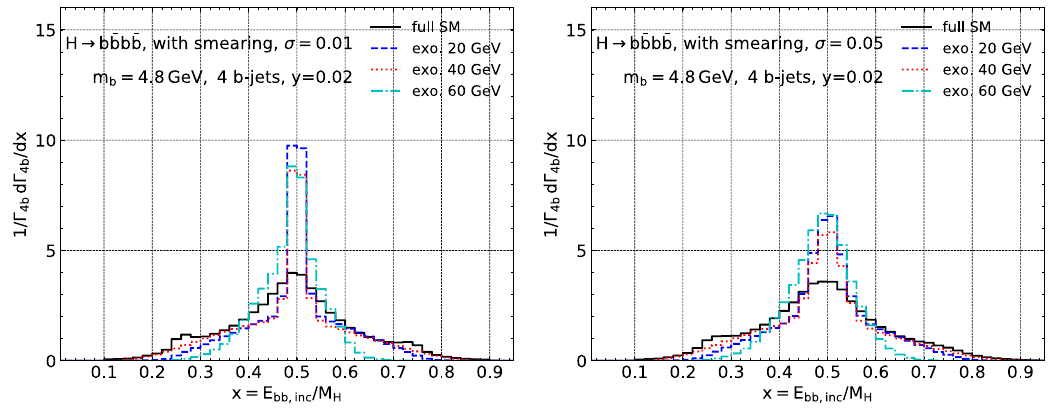
Figure 23 . Similar to figure 22 for distribution as a function of the inclusive energy of all b -jet